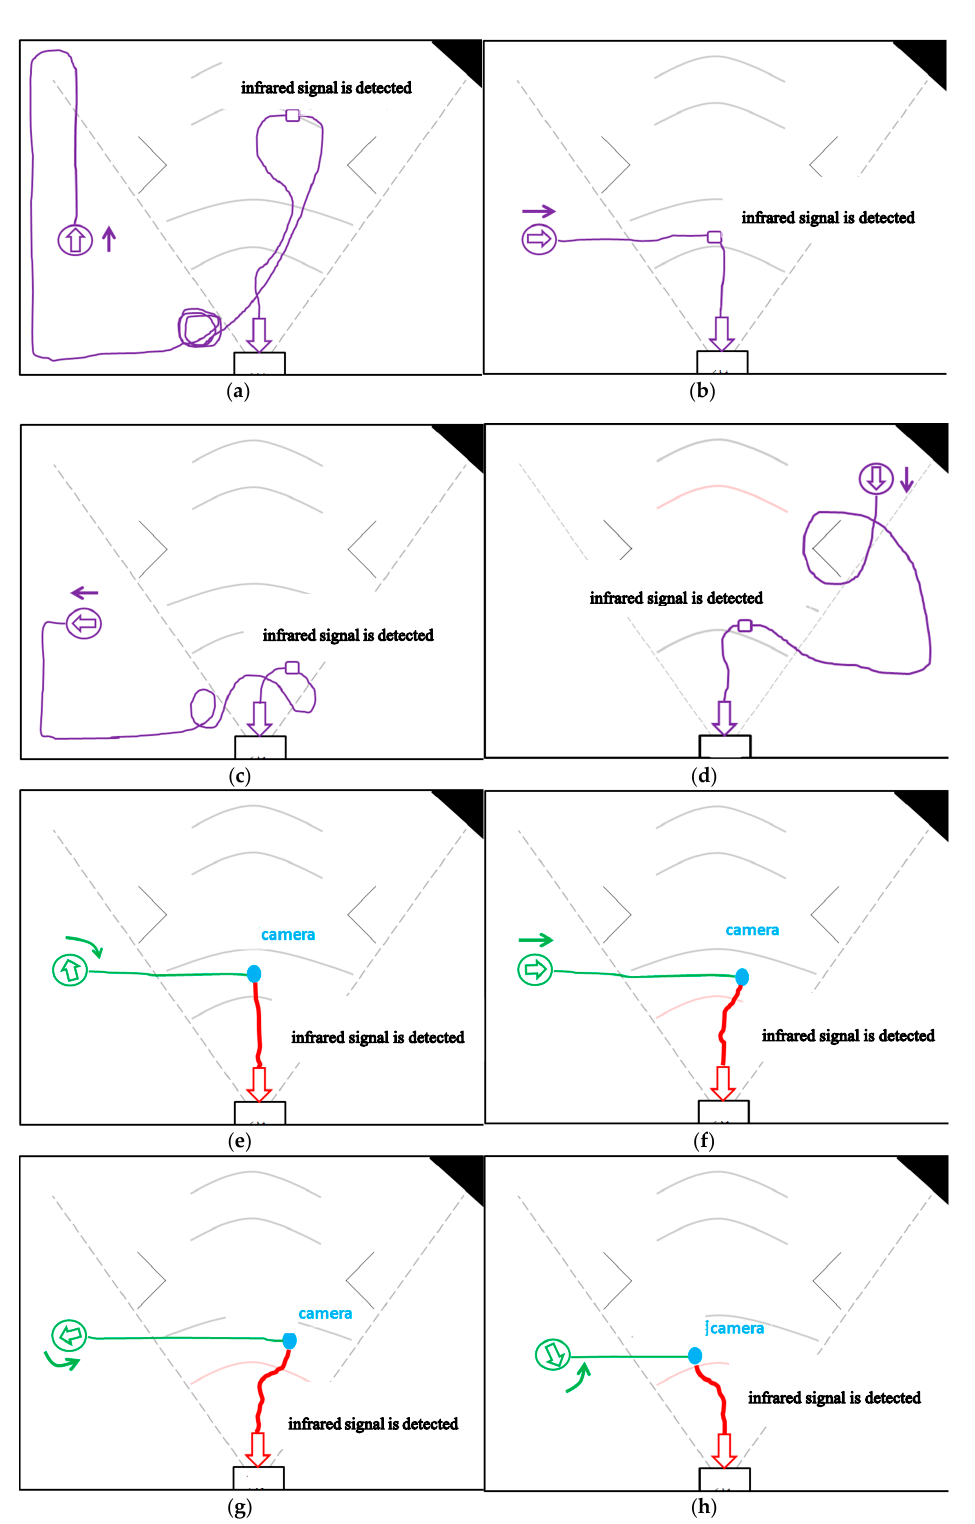
Figure 21. First part of experiment: the cleaning robot is placed outside the range of the infrared signal emitted by the infrared sensor of the docking station to back to charging by general-type and the proposed mechanisms. ( a ) Without detecting the infrared signal in the general-type mechanism, robot facing up bypasses until the infrared signal is detected. ( b ) Without detecting the infrared signal in the general-type mechanism, robot facing the right did not bypasses until the infrared signal is detected. ( c ) Without detecting the infrared signal in the general-type mechanism, robot facing the left bypasses until the infrared signal is detected. ( d ) Without detecting the infrared signal in the general-type mechanism, facing down bypasses until the infrared signal is detected. ( e ) By the proposed mechanism, robot facing up determines which direction should be followed and then finishes the recharge action. ( f ) By the proposed mechanism, robot facing the right determines which direction should be followed and then finishes the recharge action. ( g ) By the proposed mechanism, robot facing the left determines which direction should be followed and then finishes the recharge